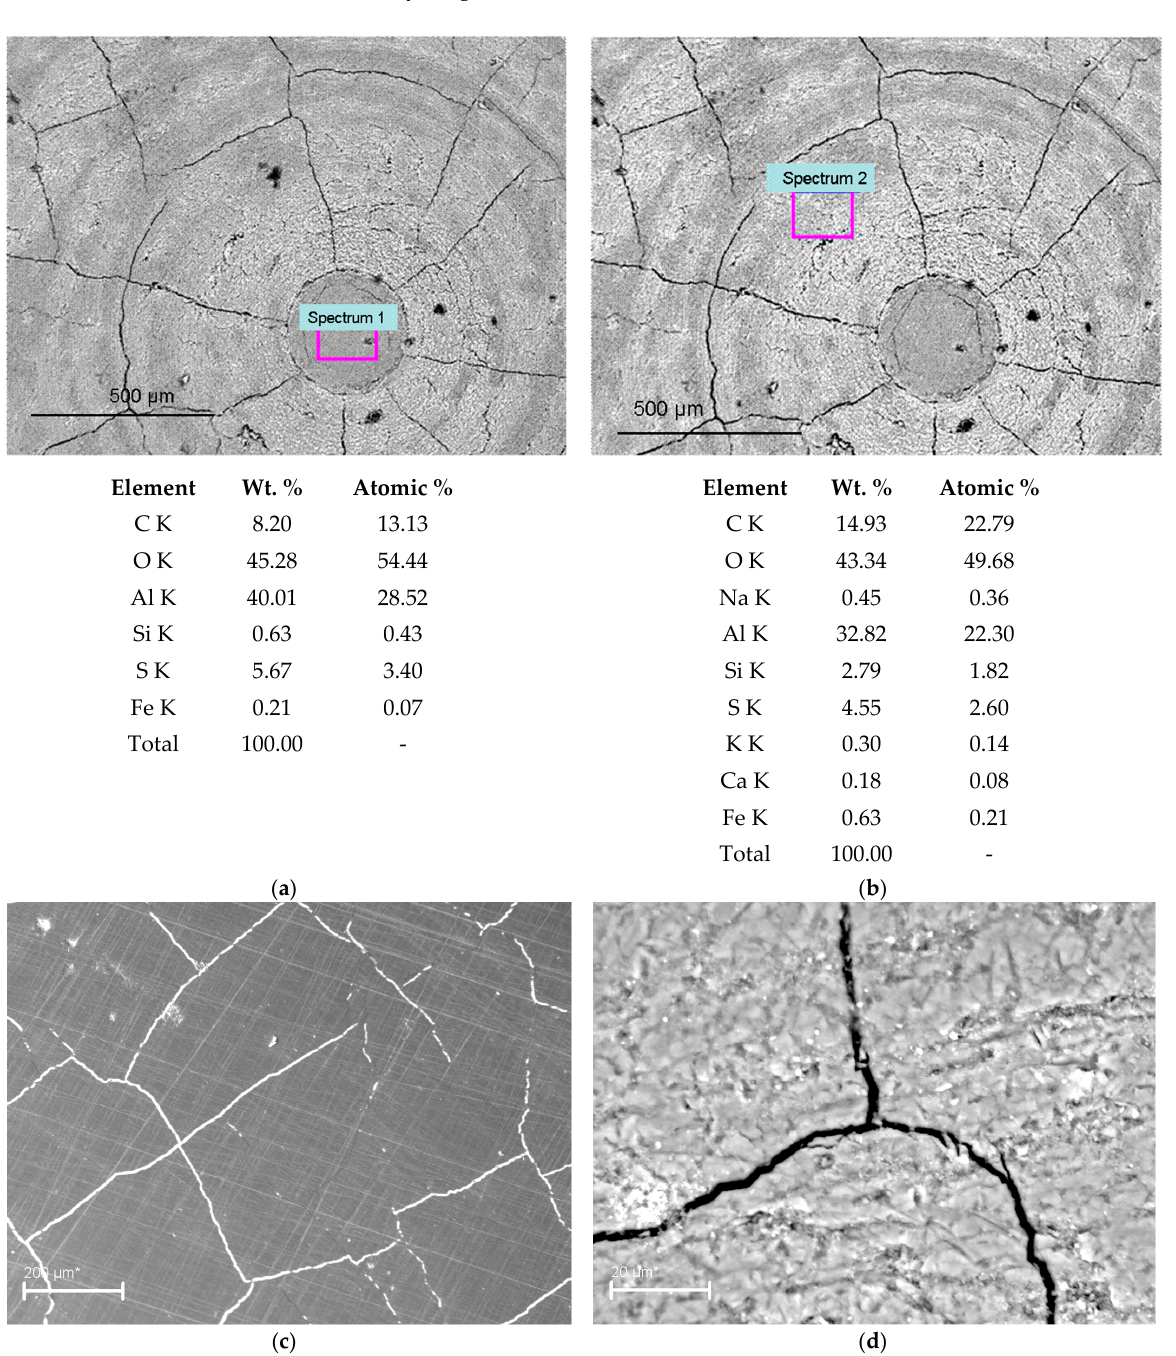
Figure 12. ( a , b ) Morphological features of the network of cracks in the hard anodized layer from the side of its outer surface with the results of micro-X-ray spectral analysis over the area different parts of the layer surface and ( c , d ) details of cracking at a higher resolution. The anodized layer was synthesized at − 4–0 °C for 2 h, followed by heat treatment at 300 °C for 1 h. The results of the phase analysis of specimens without and after heat treatment, presented above in Figures 8 and 9, convincingly confirmed the dehydration of the anodized layer after heating, causing a decrease in its volume. The base of the 1011